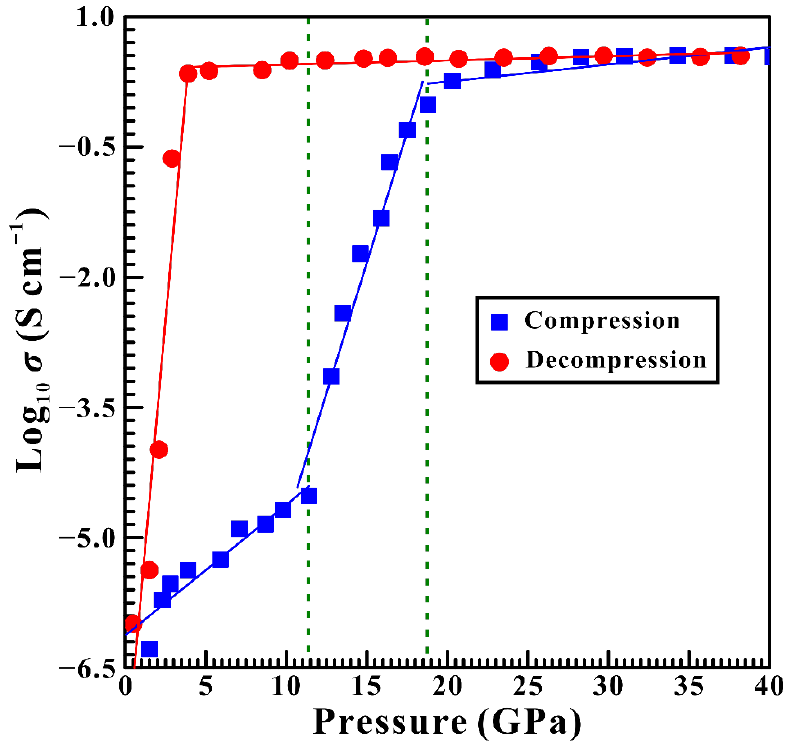
Figure 6. The logarithm of electrical conductivity of Ga 2 Se 3 as a function of pressure at atmospheric temperature under both compression and decompression.